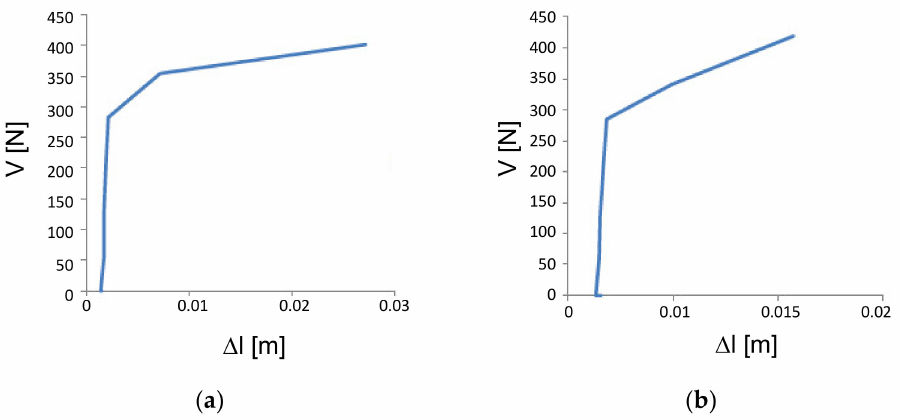
Figure 22. Relative displacement between pillars ( ∆ l ) vs. shear ( V ) obtained with the two hypotheses of interventions: ( a ) Sol (i); ( b ) Sol